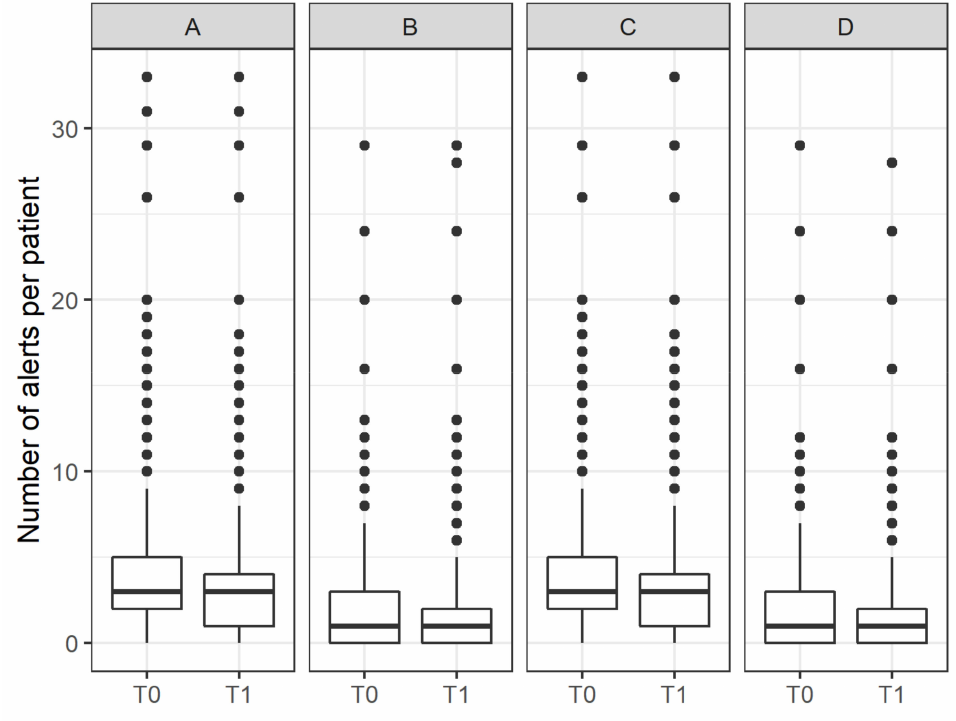
Figure 2. Box plot showing the number of alerts per patient at T 0 and T 1 ( A ), stratified according to the subgroups “severe alerts” ( B ), “completed anamnesis” ( C ), and a combination of both subgroups ( D ).